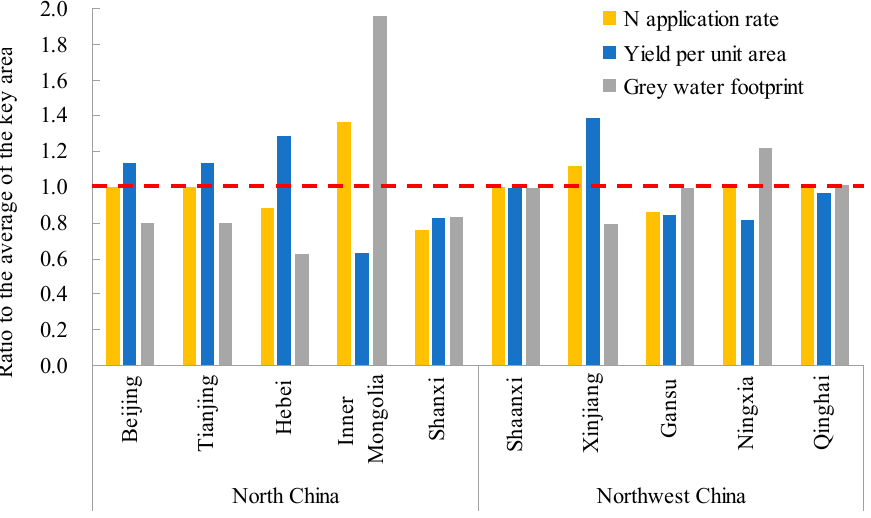
Figure 7. Fold-change of the ratio of factors affecting WF grey of wheat production to divisional average in provinces of North China and Northwest China.